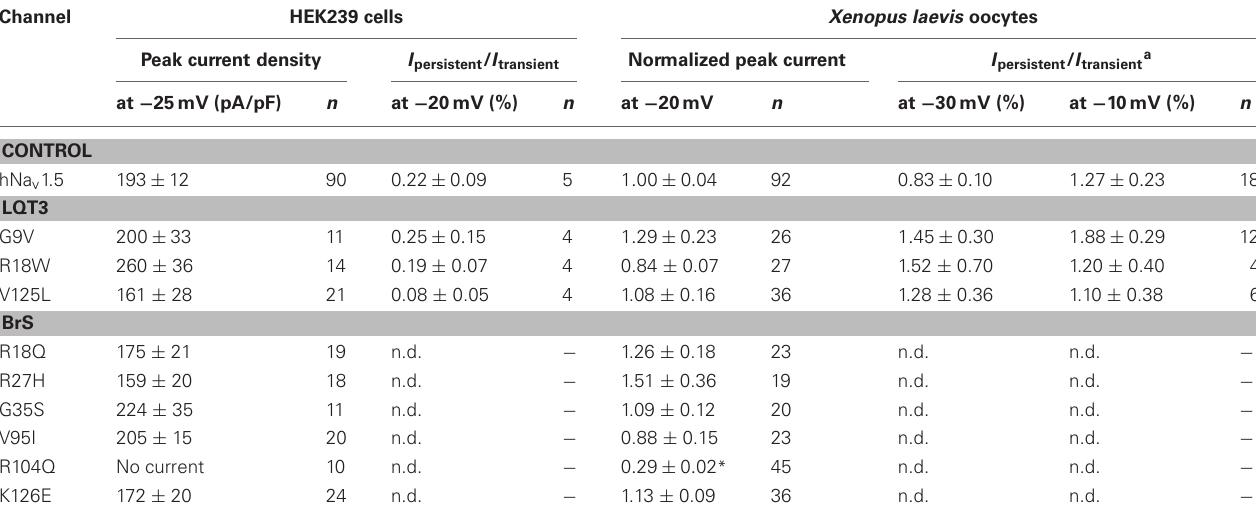
Table 1 | Peak current densities and persistent currents in HEK293 and Xenopus laevis oocytes. Channel HEK239